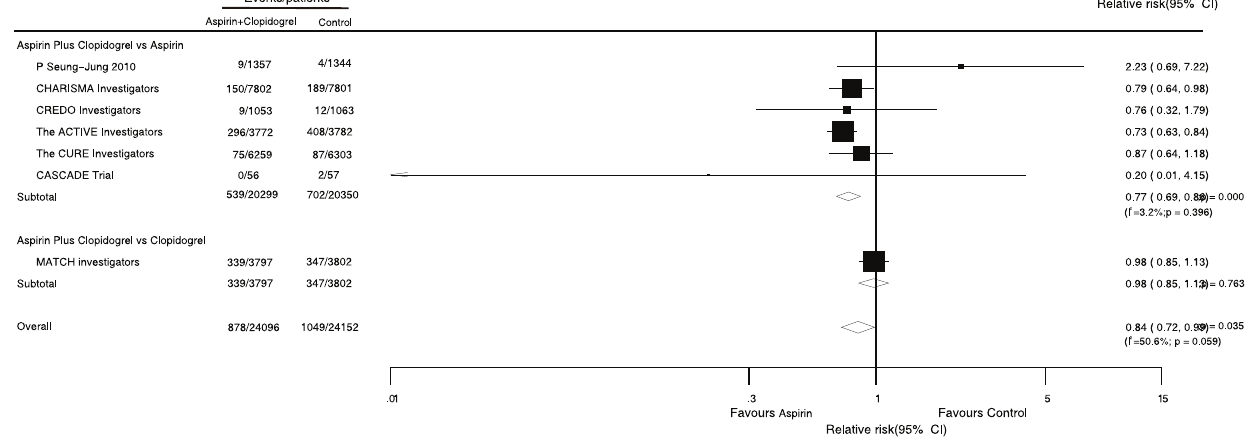
Figure 4. Effects of aspirin with clopidogrel therapy on risk of stroke.